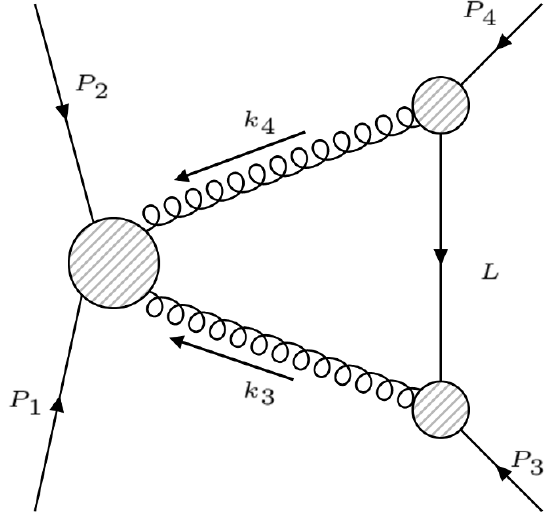
Figure 3. The box and triangle leading singularities can be computed from the triple-cut